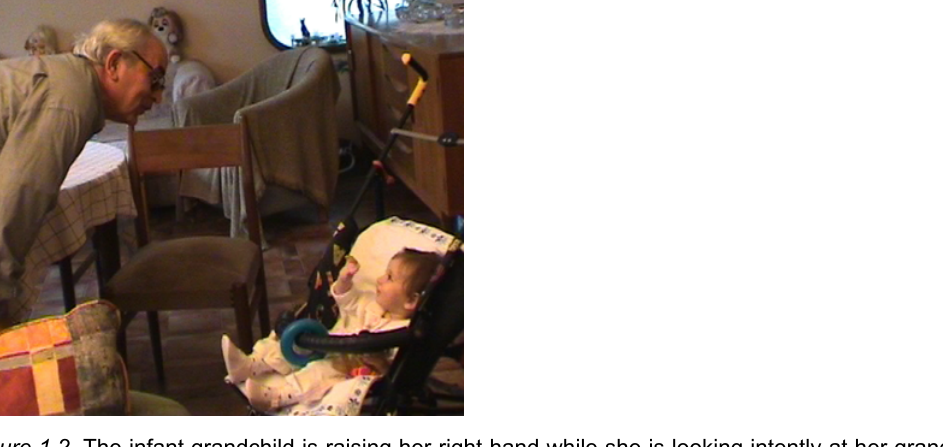
Figure 1.2. The infant grandchild is raising her right hand while she is looking intently at her grandfather who is still leaning towards her and is focused on her with a facial expression of